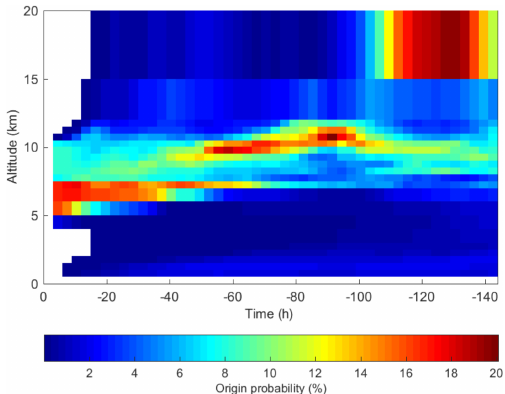
Figure 11. As in Fig. 8, except for the initial time 31 July at